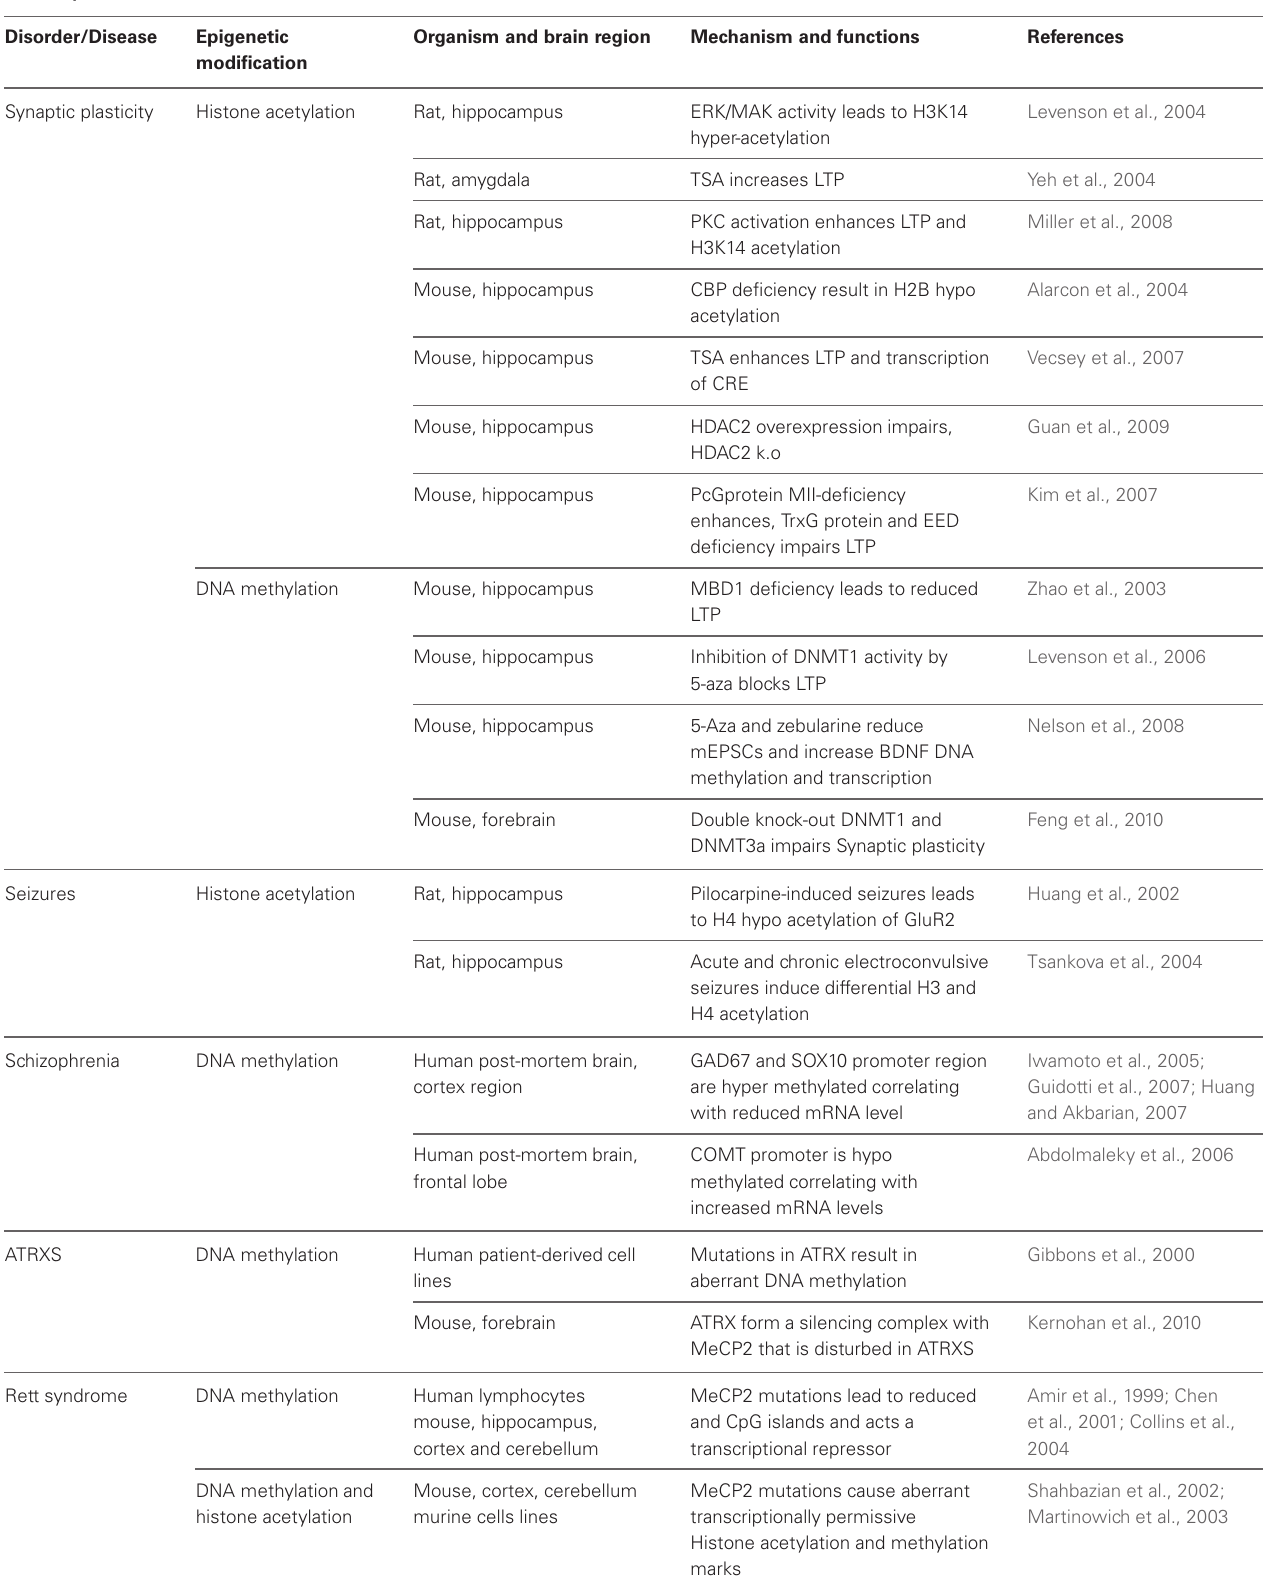
Table 4 | Epigenetic mechanism in neuronal